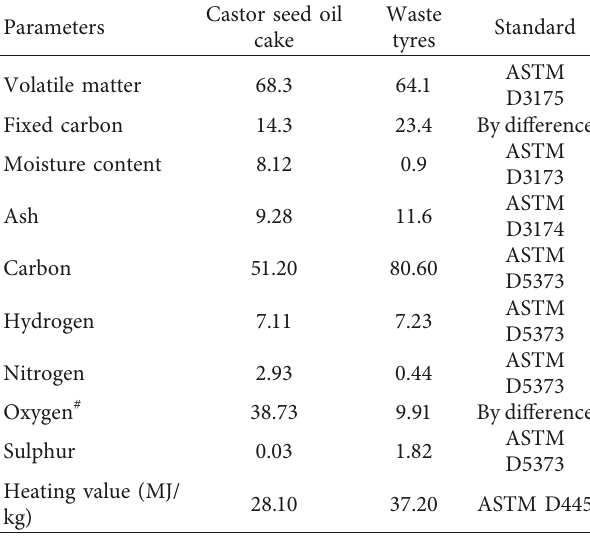
Table 1: Feedstock